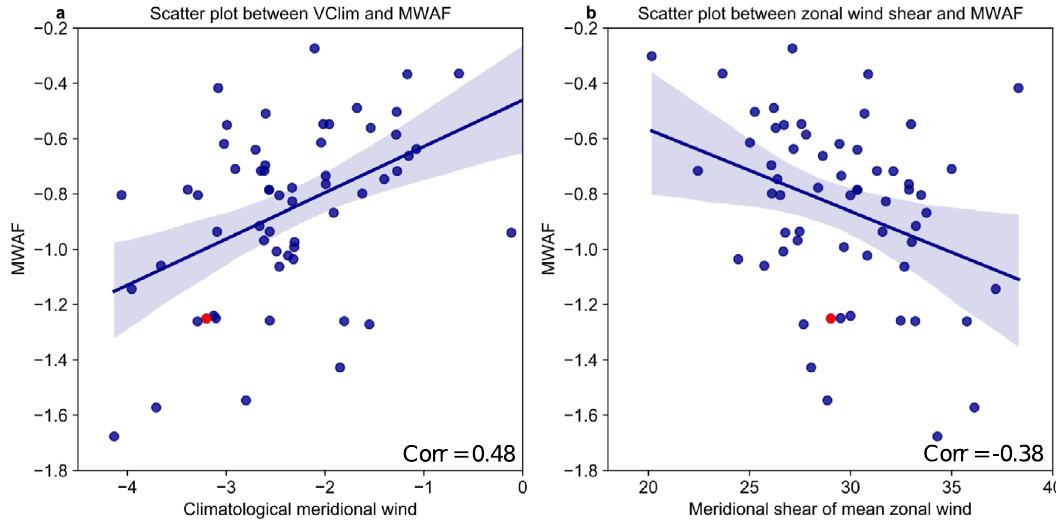
Fig. 10 Relation of climatological wind and MWAF in CMIP5/6. a Scatter plot of climatological meridional winds over 180°W – 140°W, EQ – 20°N versus MWAF averaged over 160°E – 140°W, 5°N – 20°N for 59 models. b Scatter plot of meridional shear of zonal wind versus MWAF. Meridional shear of zonal wind is calculated from the difference of climatological zonal wind in Fig. 9c. Linear regression lines are shown with their 90% con fi dence intervals (shaded) using the bootstrap method.